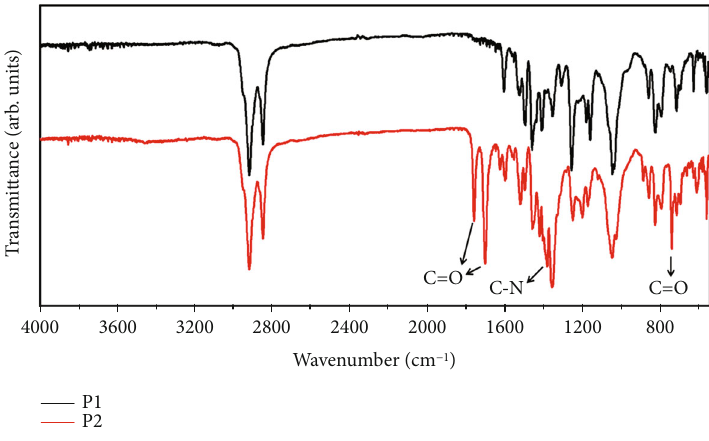
Figure 3: FT-IR spectra of polymers P1 and P2